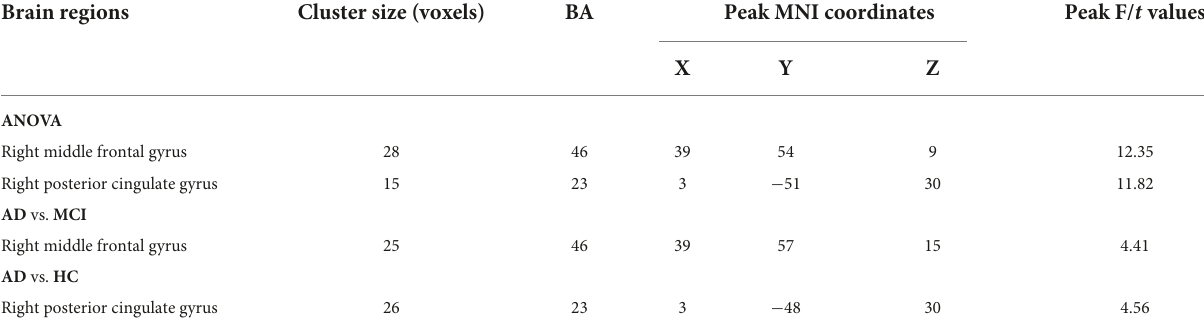
TABLE 2 Brain regions with significant differences in dReHo among groups. Brain